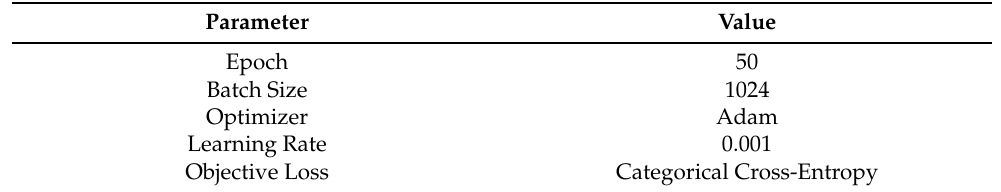
Table 8. Summary of LSTM configuration.